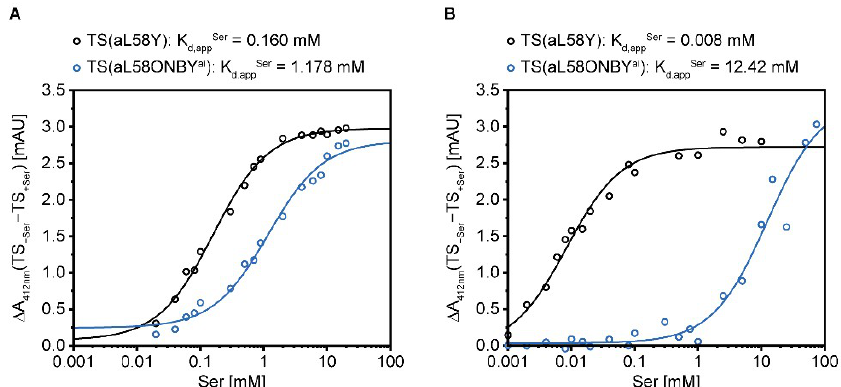
Figure 6. Absorbance titration experiments to show the influence of ONBY on binding of serine to TrpB in absence ( A ) or presence ( B ) of 100 mM cesium cations. The total change in TS absorbance at 412 nm, representative of the reduction in IA species, is plotted against the concentration of serine. The experimental data were fitted with the Hill equation (3) ( H = 1).